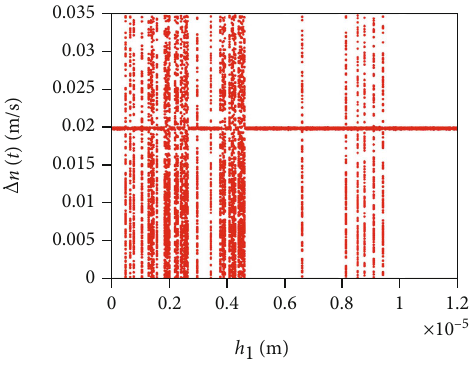
Figure 13: Bifurcation diagrams with changes in the uniform wear when the misalignment in the x direction is 3 : 2 × 10 − 4 m.